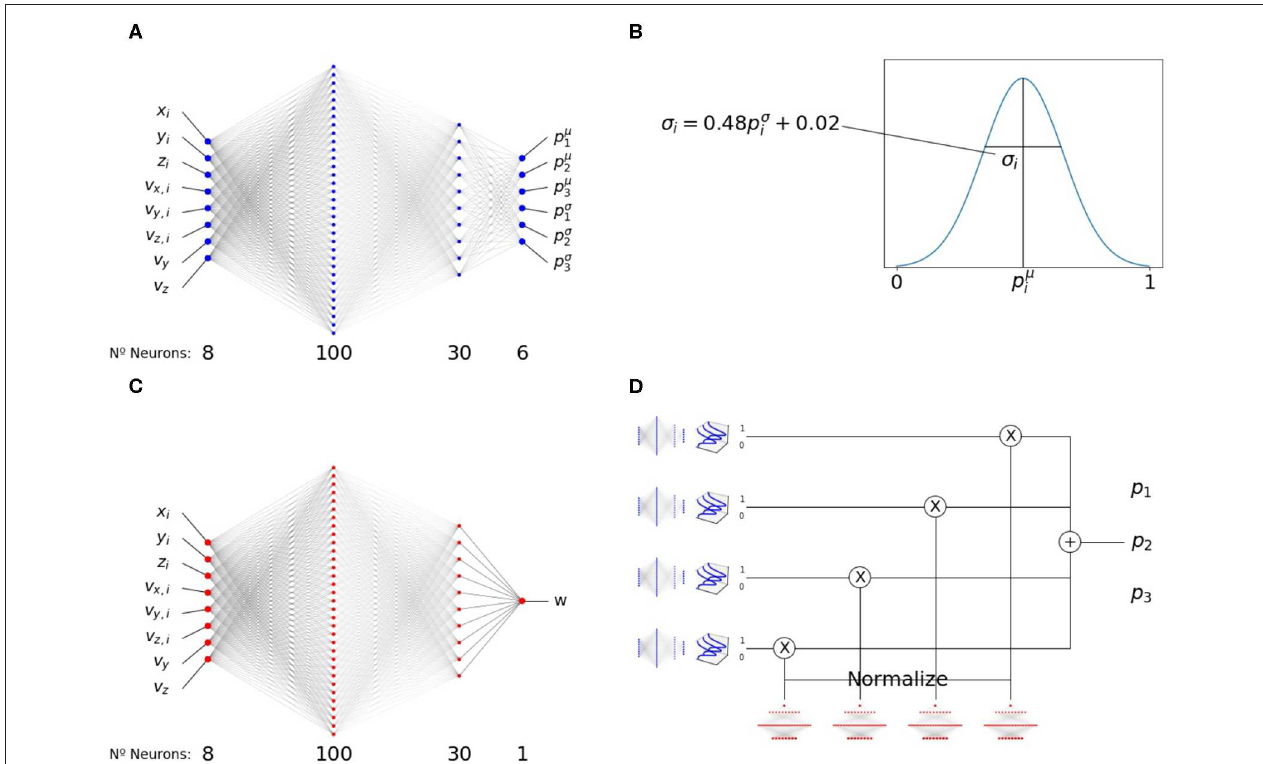
FIGURE 2 | Modular structure of the policy network. (A) Pair-interaction module, receiving asocial variables, v y and v z , and social variables, x i , y i , z i , v x , i , v y , i , v z , i , from a single neighbor i , and outputting 6 numbers (three mean values and three variance values). (B) Three numbers are sampled from three clipped Gaussian distributions with mean and variances given by the output of the pair-interaction module. (C) Aggregation module. Same structure as A, but with a single output that is passed through an exponential function to make it positive. (D) Complete structure of the modular network, showing how the outputs of the pair-interaction and aggregation modules are integrated. The resulting output, p 1 , p 2 , p 3 , determines the heading and speed of the focal fish in the next time